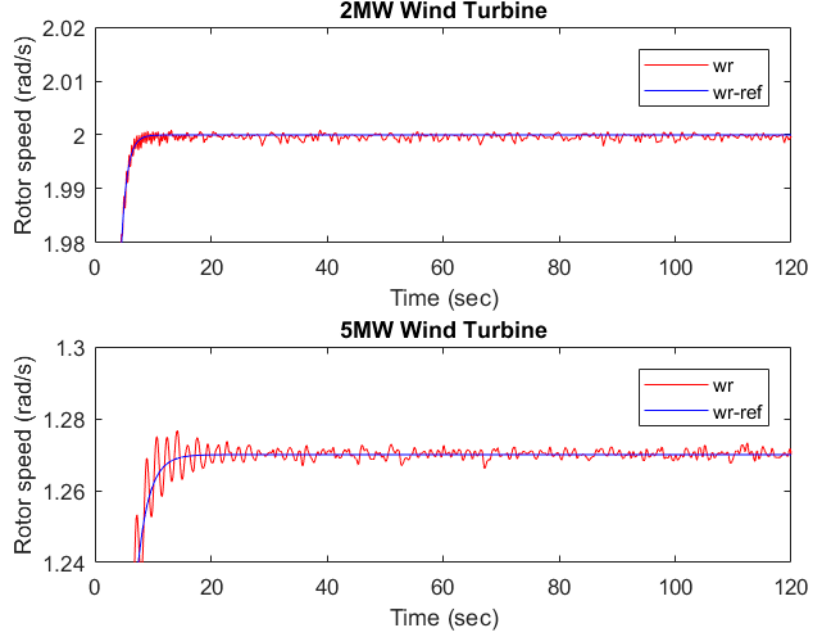
Figure 6. Steady-state rotor speed regulation of the 2 MW and the 5 MW wind turbines in region three.